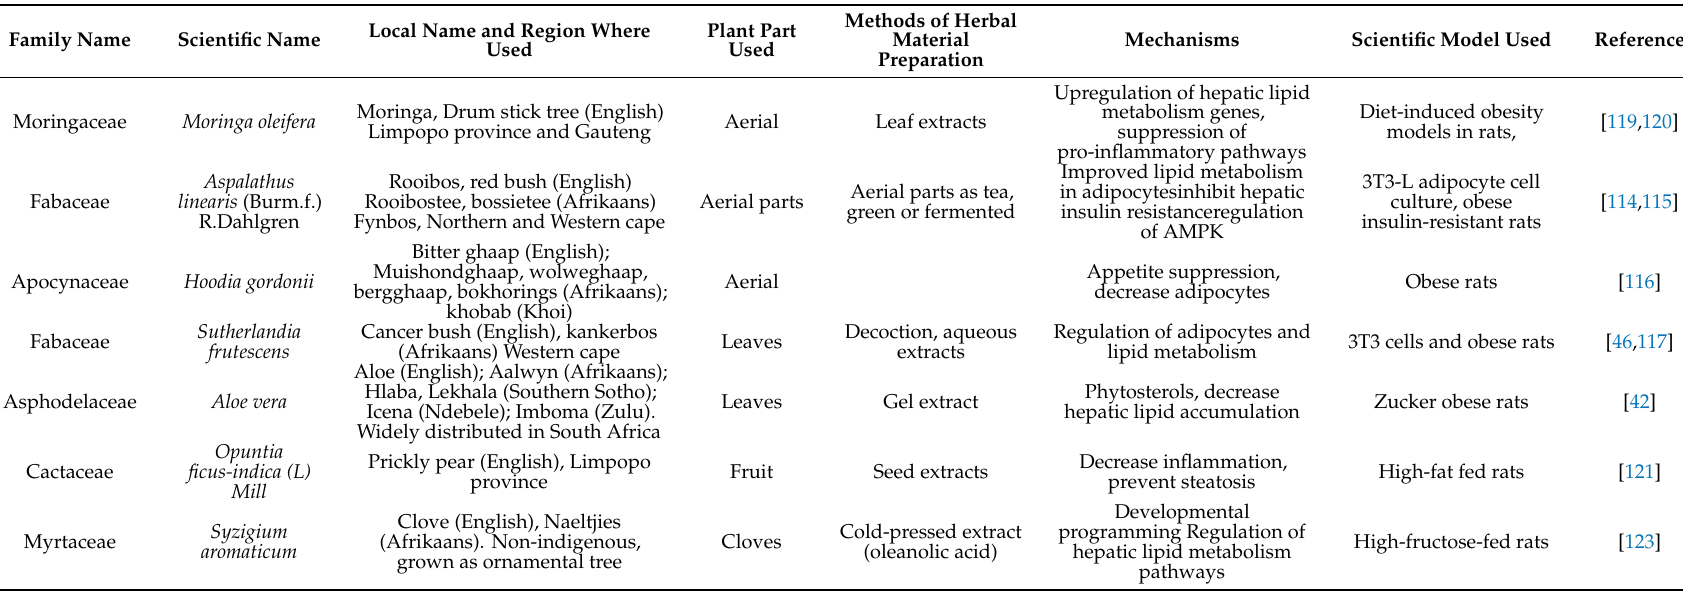
Table 4. List of plants with laboratory-tested potential for use in the treatment of non-alcoholic fatty liver disease in South Africa. AMPK, AMP-activated protein